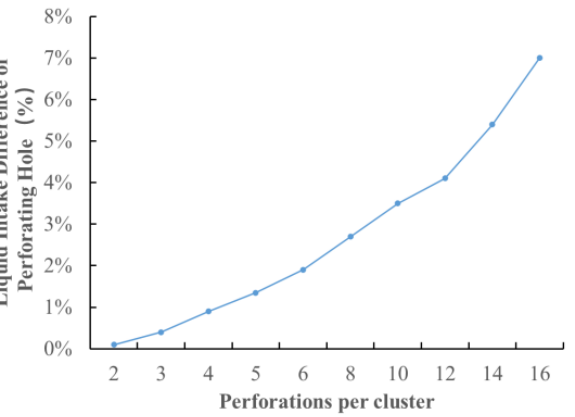
Figure 11. Difference in liquid inflow between clusters under different perforation numbers.